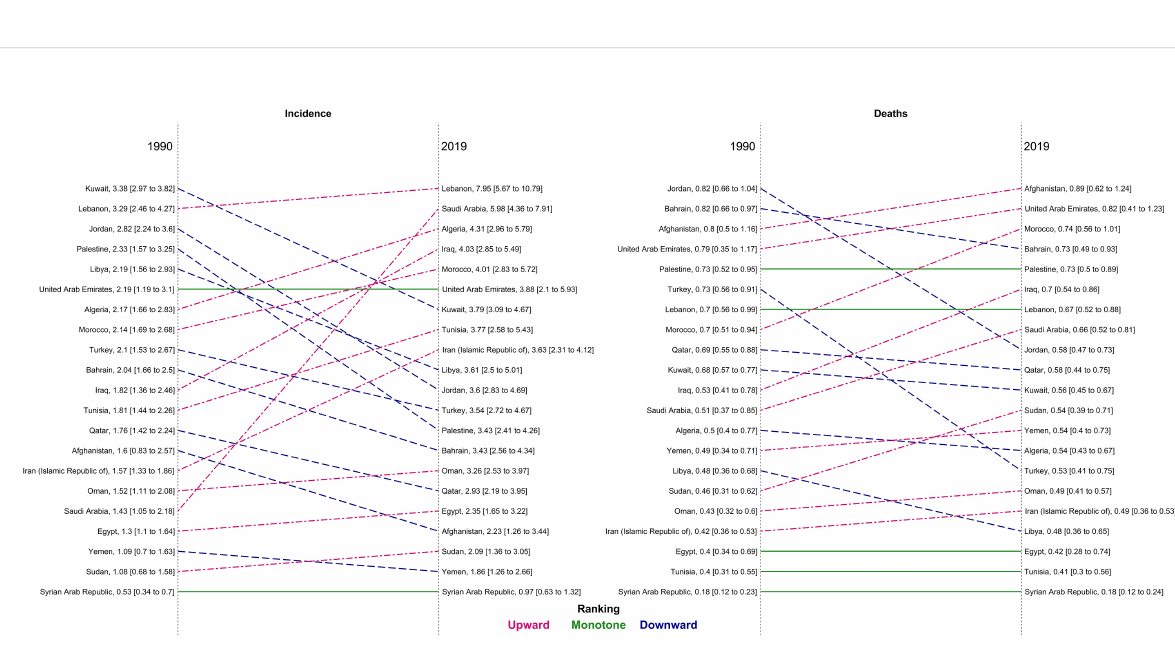
and high-middle-SDI quintiles had the greatest rate of deaths and DALYs (Figure 5). The age-standardized incidence, death, and DALY rates by HAQI in 1990 and 2019 are presented in Supplementary Figures 6 – 8,